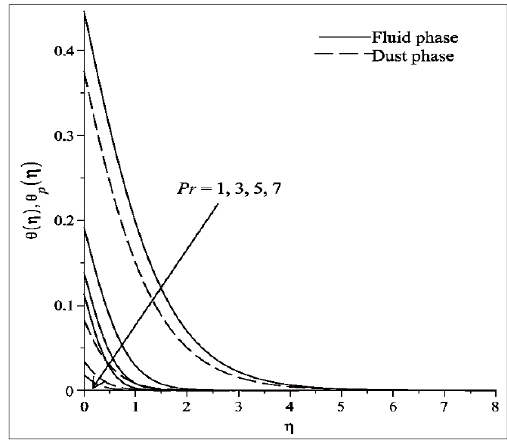
Pr Pr Figure 13. Profile on temperature for various Pr